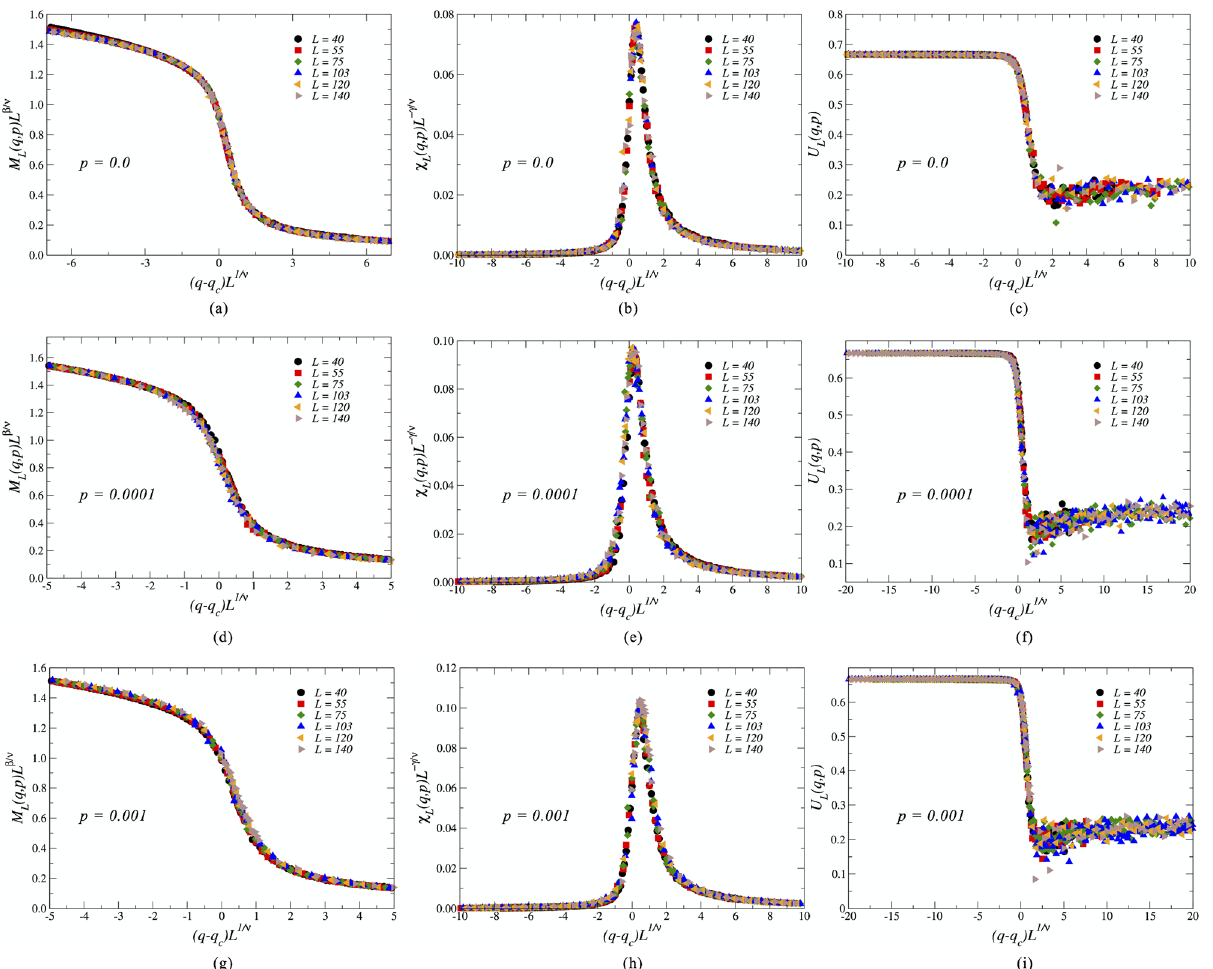
Figure 10. Data collapse into universal scaling functions for the average magnetization M L , the magnetic susceptibility χ L , and for the fourth-order Binder cumulant U L for regular square lattices, i. e., p = 0 , and for small-world interactions with rewiring probability p = 10 − 4 and p = 10 − 3